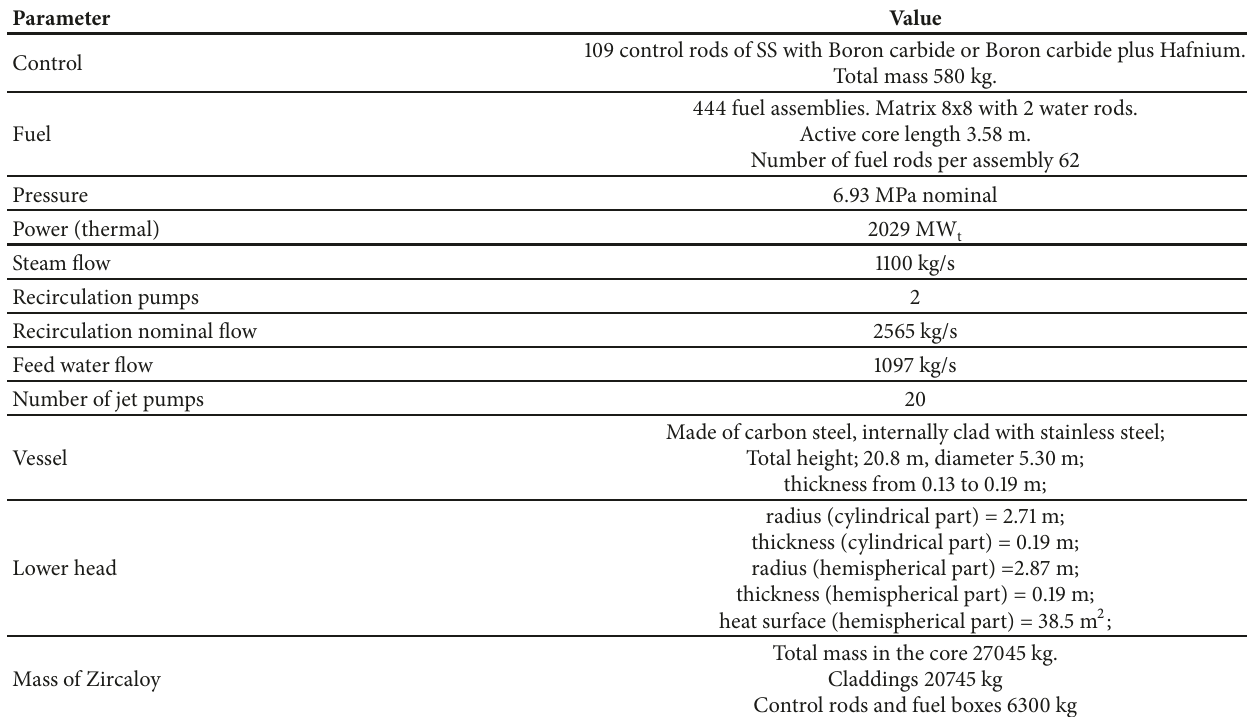
Table 1: General data of BWR-5